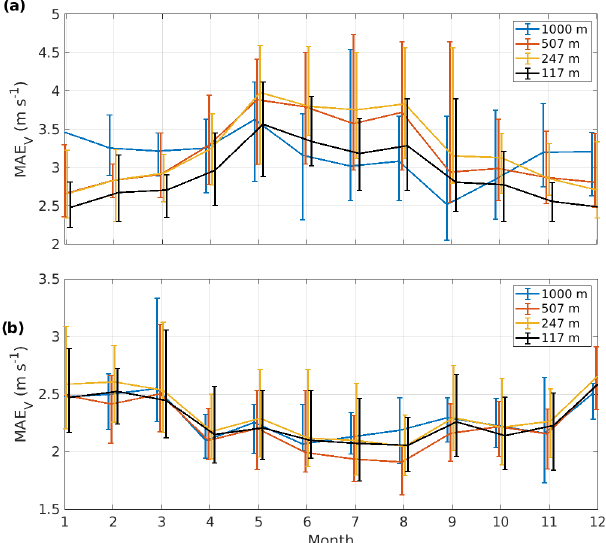
Figure 6. Monthly means of absolute wind vector error at (a) SGP and (b) Graciosa at 117, 247, 507, and 1000ma.g.l. The bars show the maximum and minimum monthly average absolute wind vector error across all years.